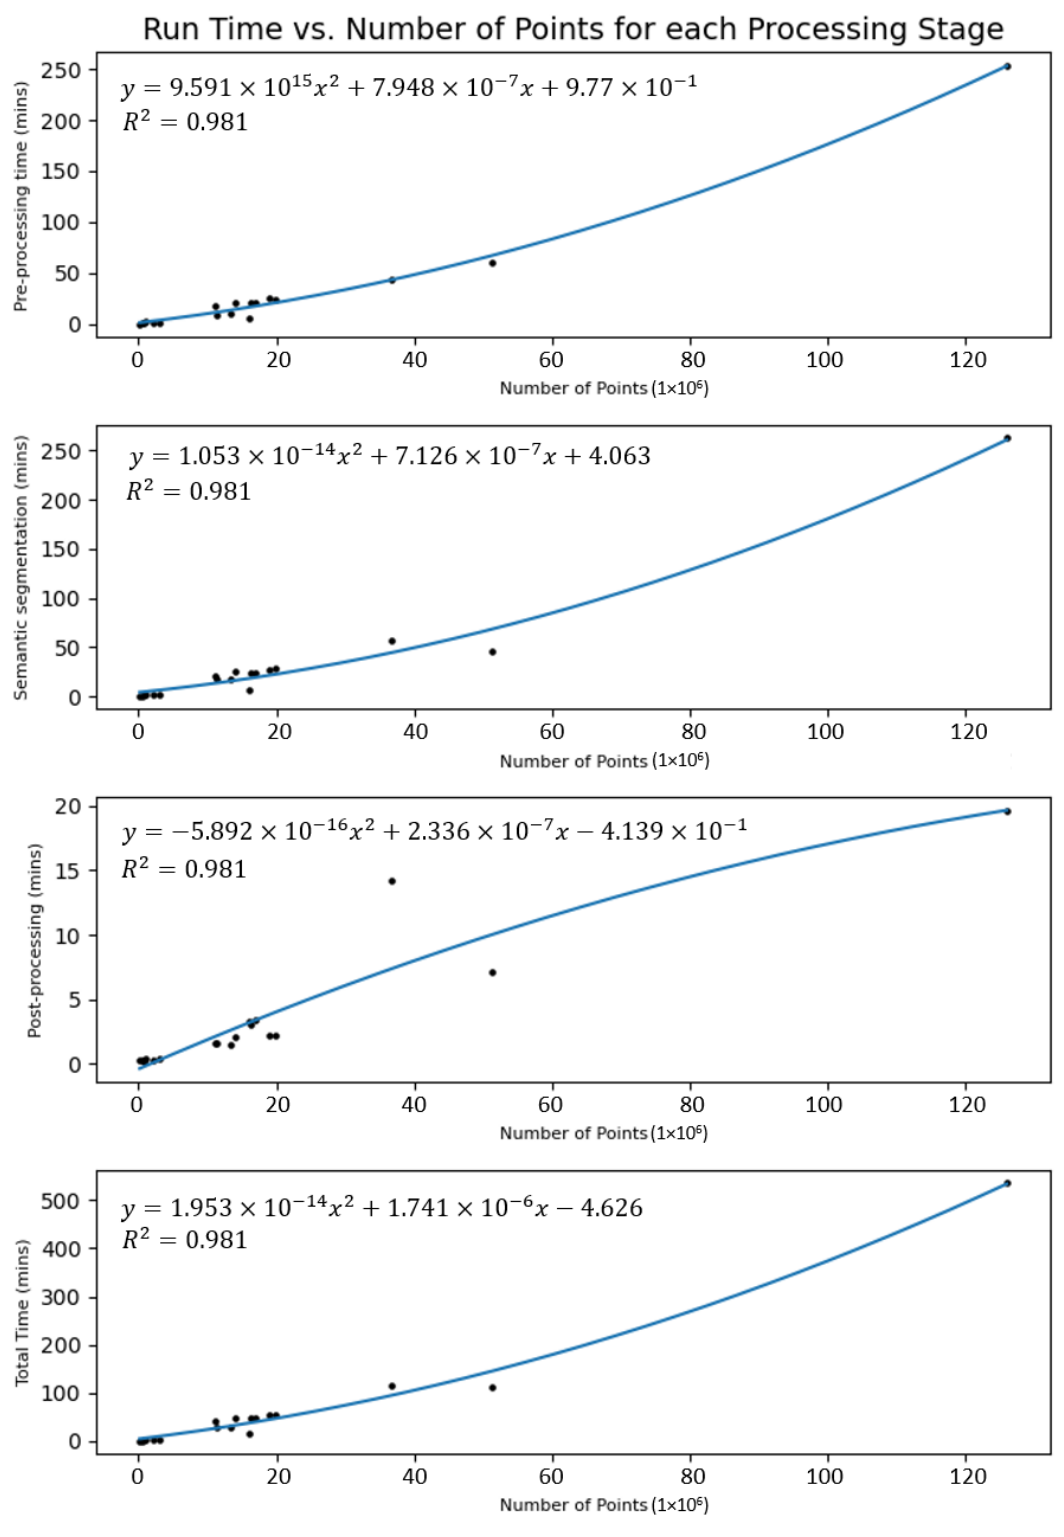
Figure A3. This figure shows the computation time of each processing step relative to the number of points (after subsampling to a 0.01 m minimum distance between points). A second-order polynomial was fitted to show the approximate trend of the data; however, the largest dataset (top right data point) exceeded the available 128 GB of RAM during the final steps of semantic segmentation, using the swap file on a solid state drive for the excess, which did slow the process.